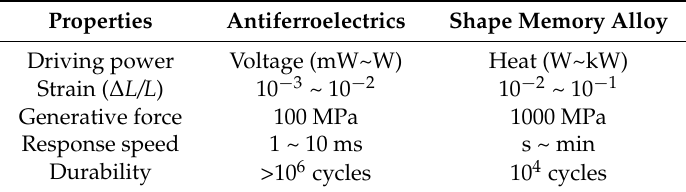
Table 2. Comparison of the shape memory characteristics between alloys and antiferroelectric ceramics.